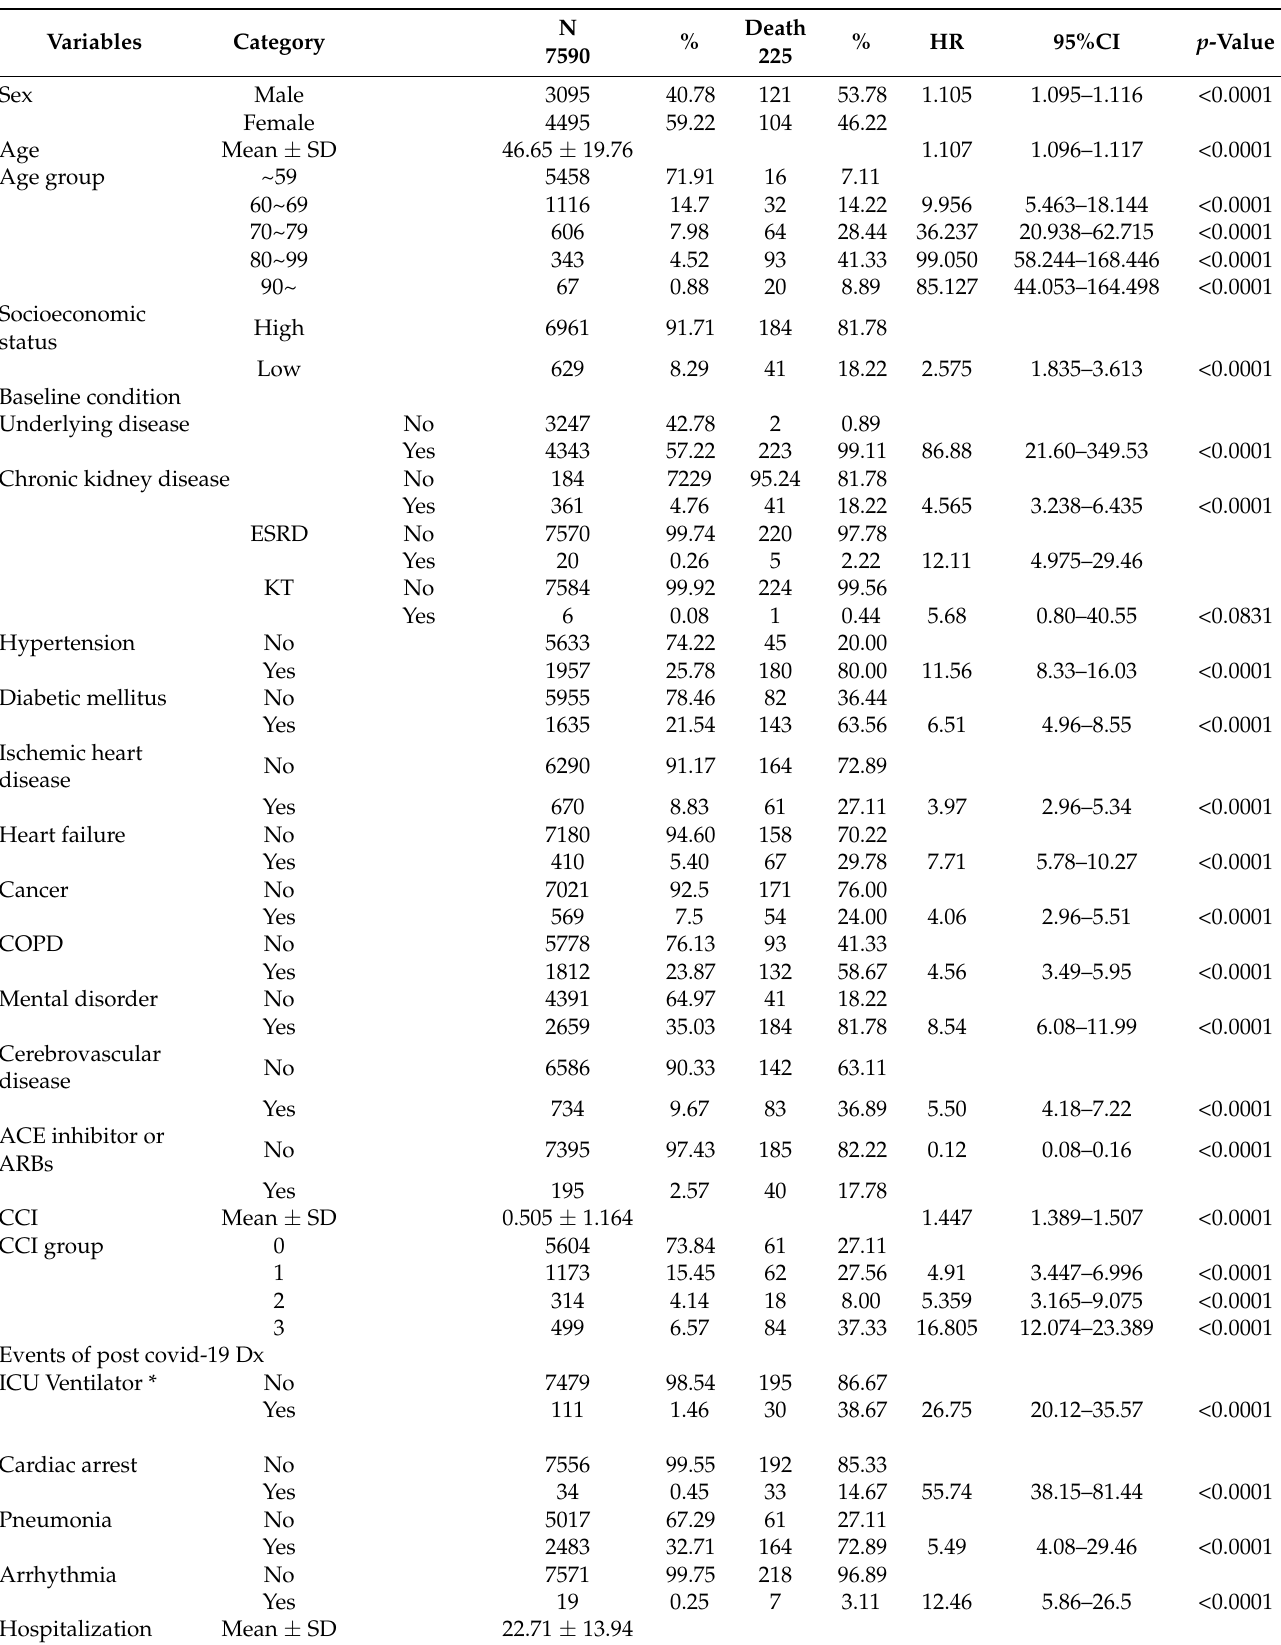
Table 1. Demographic and clinical characteristics, comorbidities, and outcomes of 7590 patients with